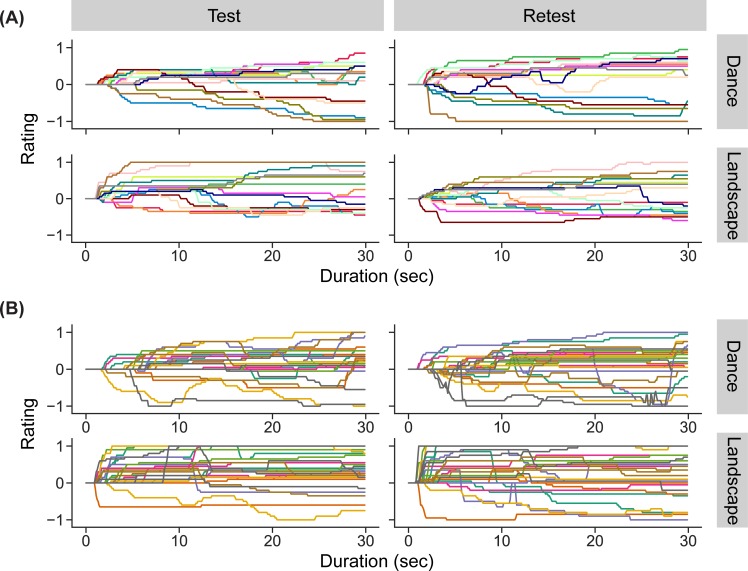
Representative continuous rating traces.(A) Continuous rating traces from one participant for each movie clip. In addition to differences in overall mean liking, some movies elicited more temporal dynamics than others. Rows show different categories (Dance, Landscape) and columns show ratings for different sessions. (B) Continuous rating traces given by each participant for one dance and one landscape clip. These movie clips were rated remarkably differently by different participants, both in terms of its overall mean liking, but also in terms of variability over time. Each row shows a sample movie from one genre (Dance, Landscape) and columns show ratings for different sessions.